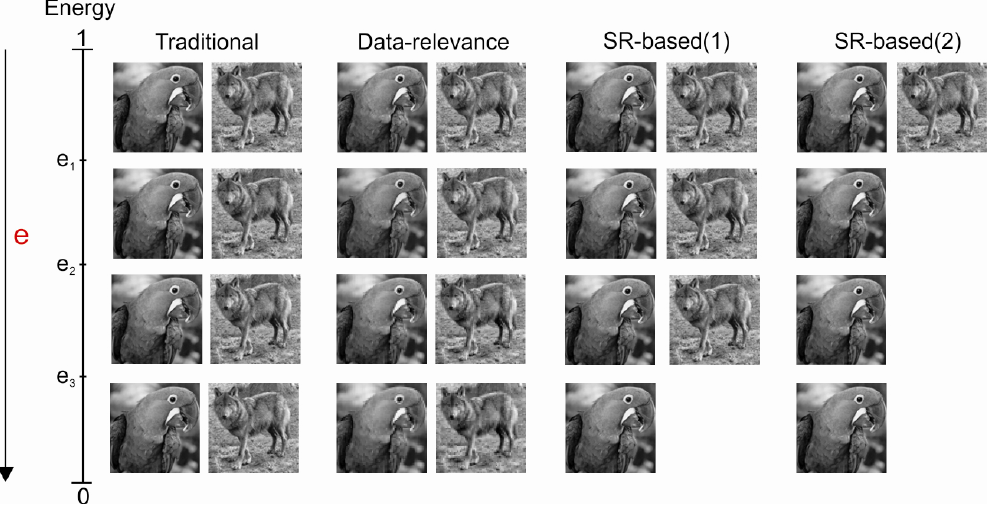
Figure 8. Average quality of the images that reach the sink for different transmission